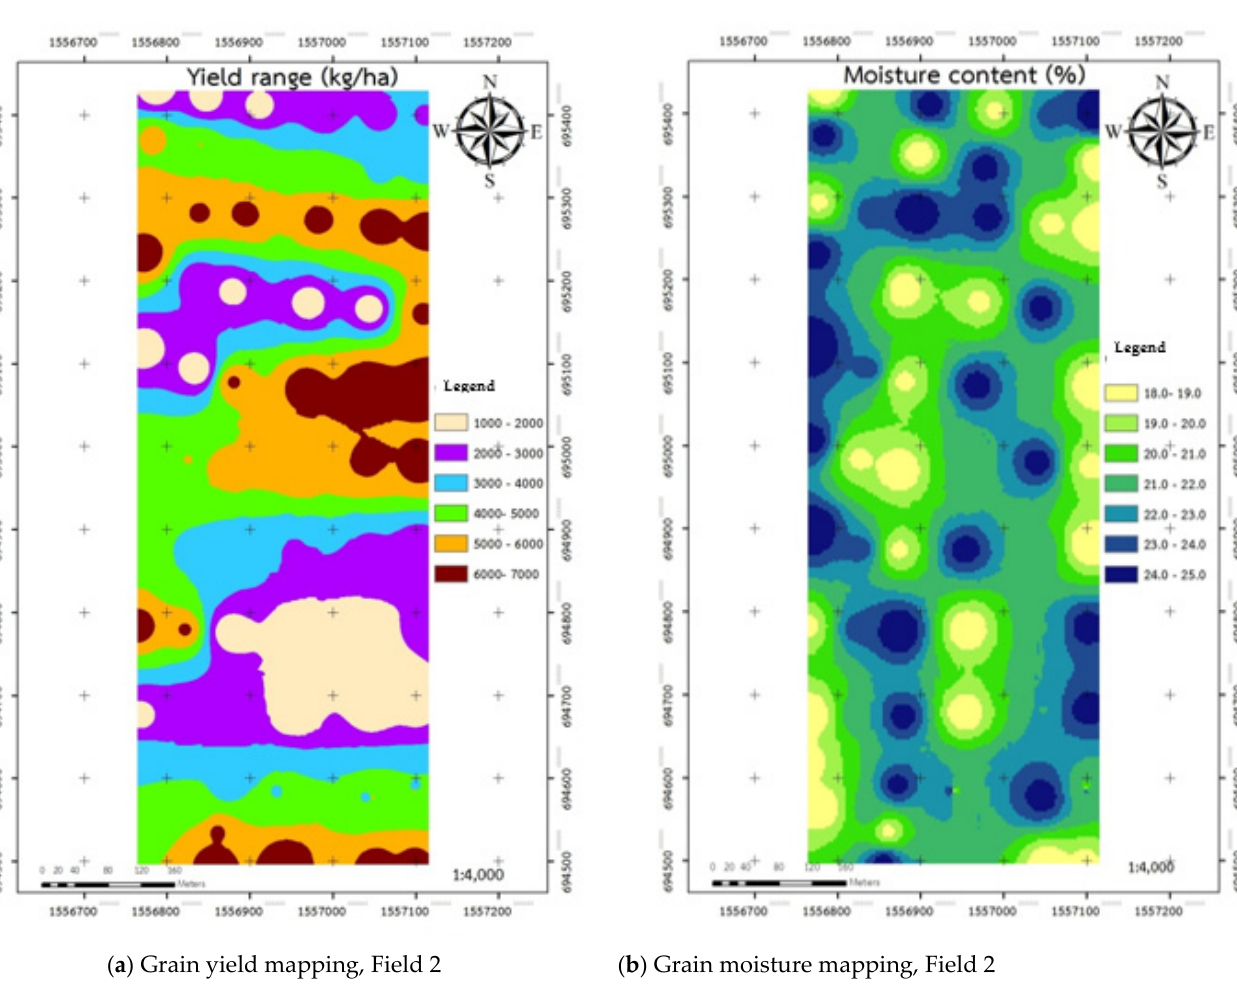
Figure 10. Yield and moisture content variation of plantation of 0.4 ha.